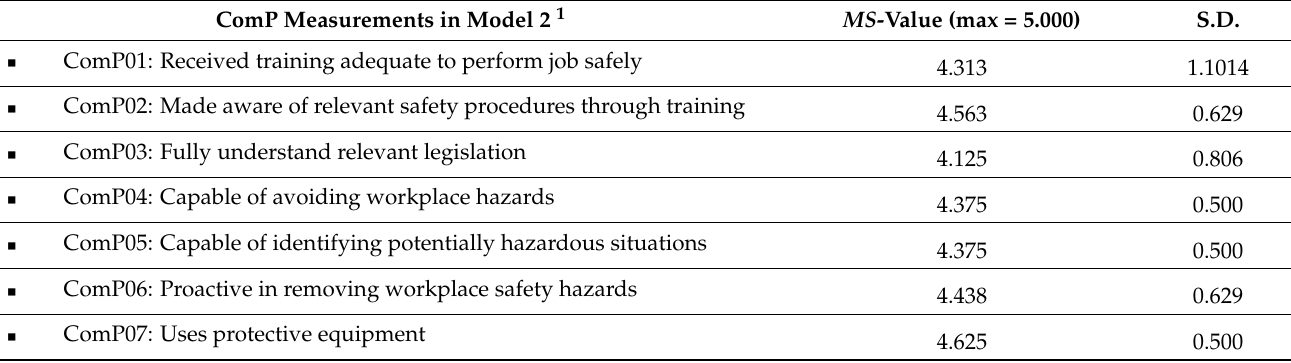
Table 7. Importance of ComP Measurement in Model 2 (Adopted from Mohamed, 2002 [8]). ComP Measurements in Model 2 1